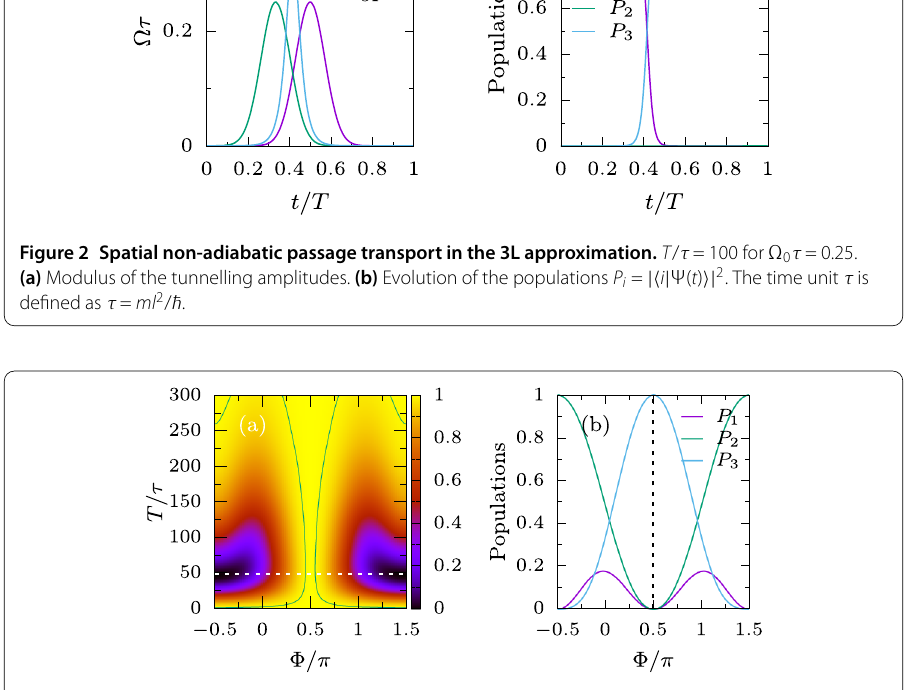
Figure 3 Transport process | 1 (cid:2) → – | 3 (cid:2) in the 3L approximation. (a) Fidelity as a function of the total time and the total magnetic phase traversing the system. The green contour line is defined by P 3 = 99%. (b) Probabilities of population in each of the traps for T / τ = 48 (indicated by a dashed white line in (a)) as a function of the total magnetic phase traversing the system. The dashed black line indicates the optimal value of the phase Φ = π